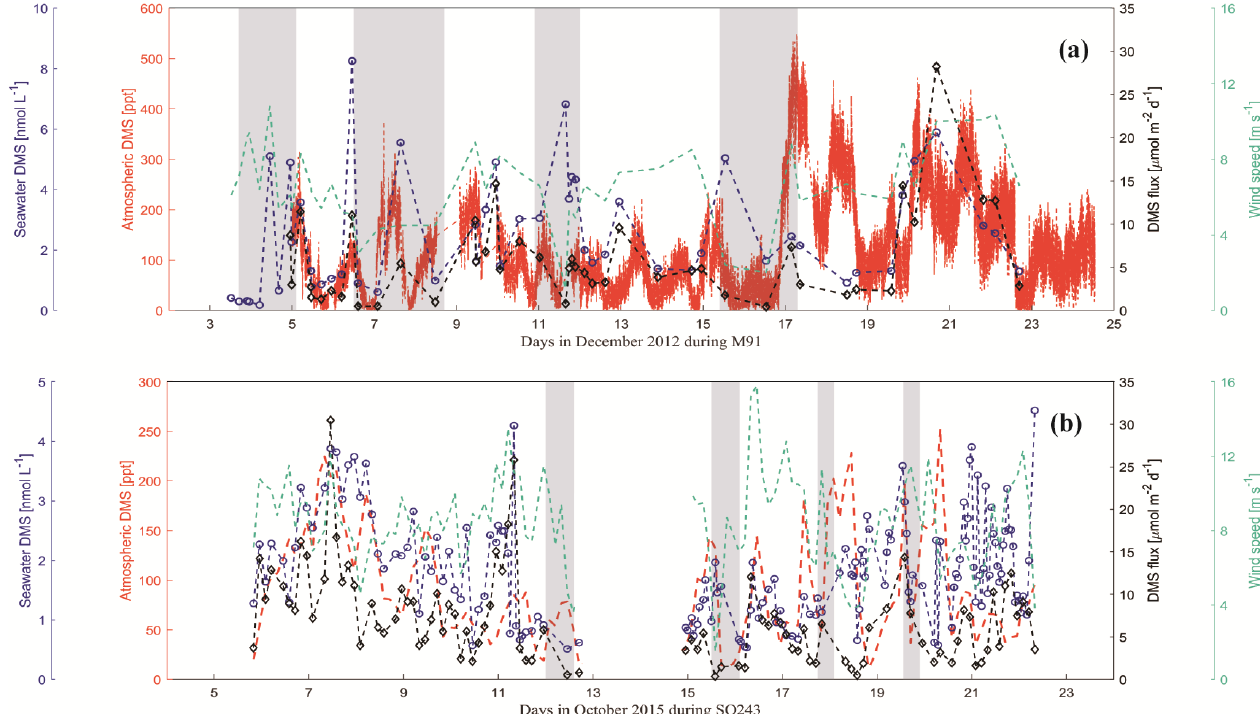
Figure 7. Atmospheric DMS mole fractions (red dash line), surface seawater DMS concentrations (blue circles) and DMS fluxes (black diamonds), and wind speeds (green dash line) during the cruises M91 (a) and SO243 (b) . Grey rectangles (a, b) indicate coastal CTD stations for both cruises. Note that DMS mole fractions during M91 were averaged for 10min to calculate